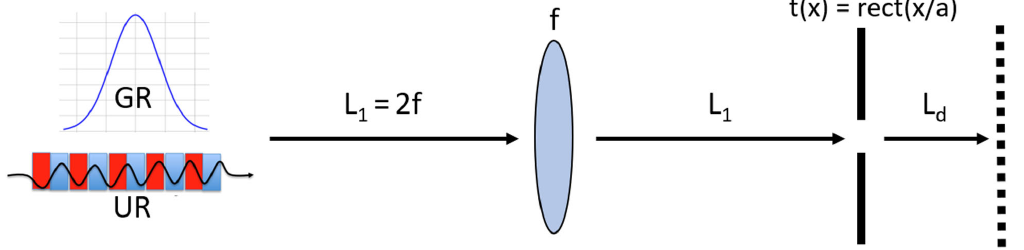
FIG. 2. Simple matrix-aperture beam line example.